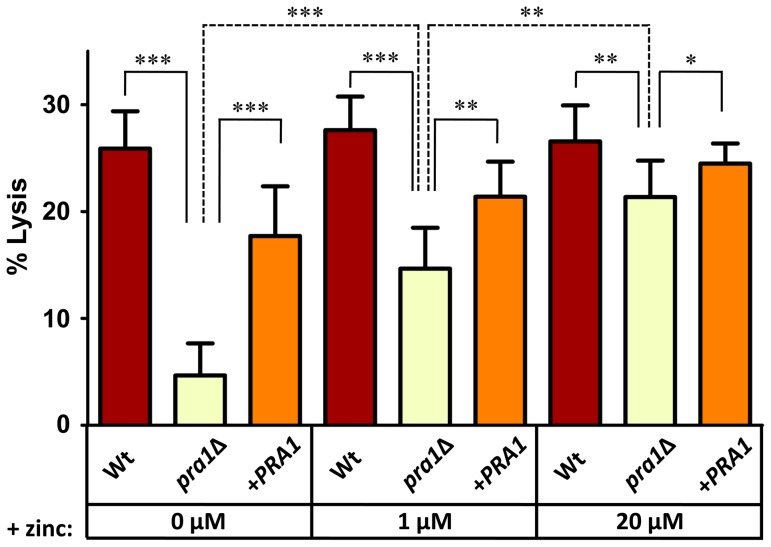
Endothelial damage is zinc-dependent in the absence of PRA1.Endothelial monolayers were infected with wild type (M134), pra1Δ (M1809) or pra1Δ+PRA1 (M1785) C. albicans in zinc-free medium with indicated zinc-supplementation. Following 24 h co-incubation, endothelial damage was assessed by measuring the release of lactate dehydrogenase. Experiment was performed 3 times in triplicate. Asterisks indicate significance by Student's t-test: * <0.05; ** <0.01; *** <0.001.